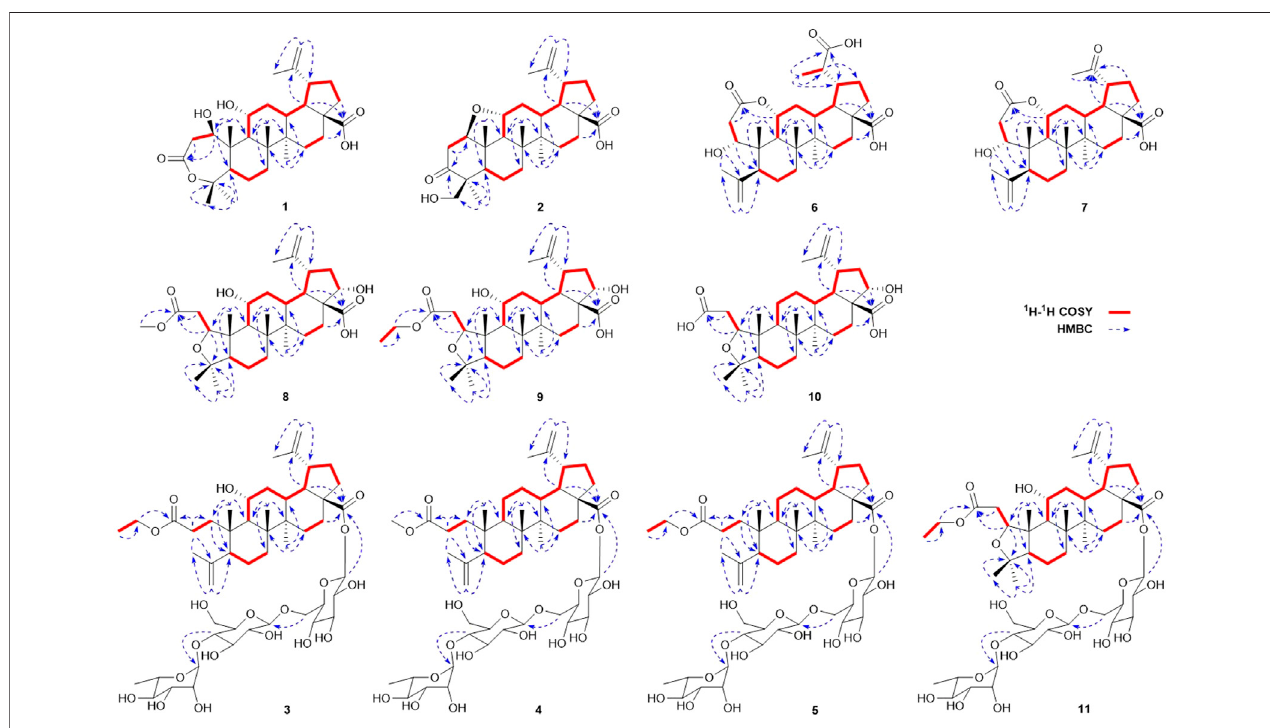
FIGURE 2 | Key 1 H- 1 H COSY and HMBC correlations of compounds 1 - 11 .